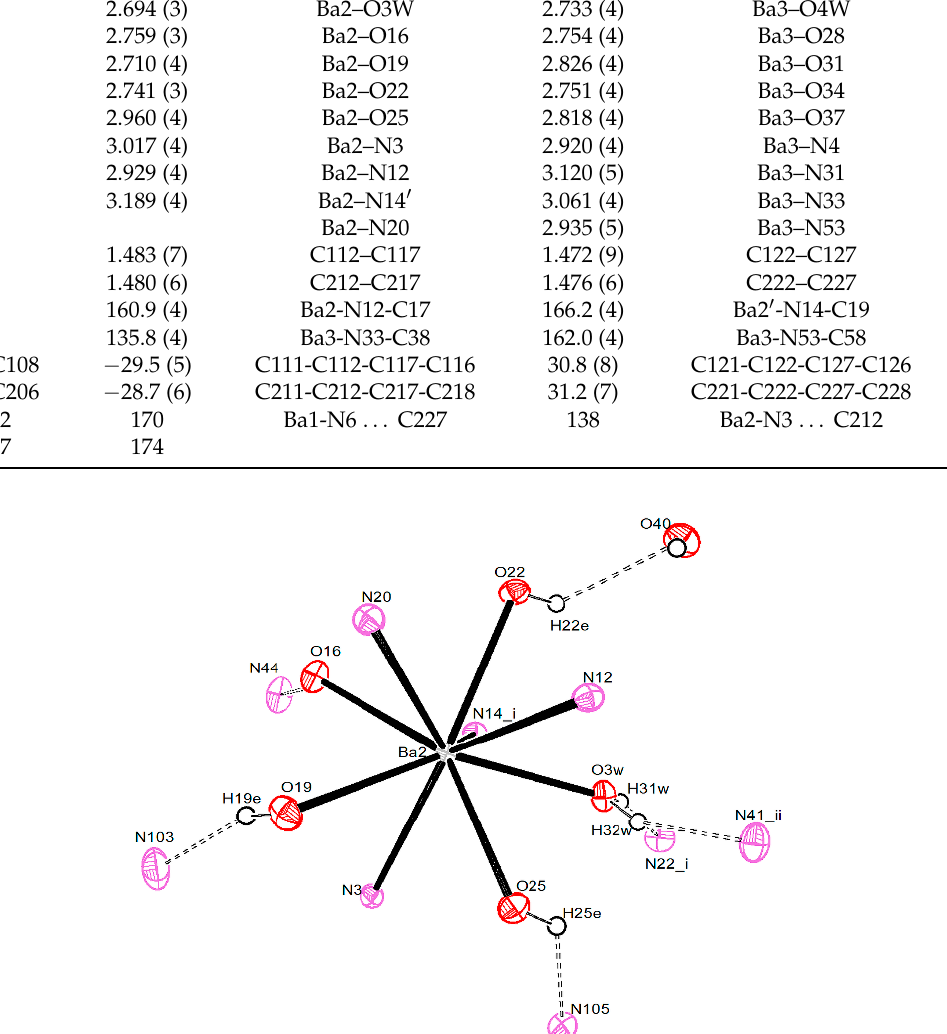
Figure 21. The first and second coordination spheres of Ba2. Symm. Operators: i: x , 1 − y , z − ½ ; ii: x , − y , z + ½.